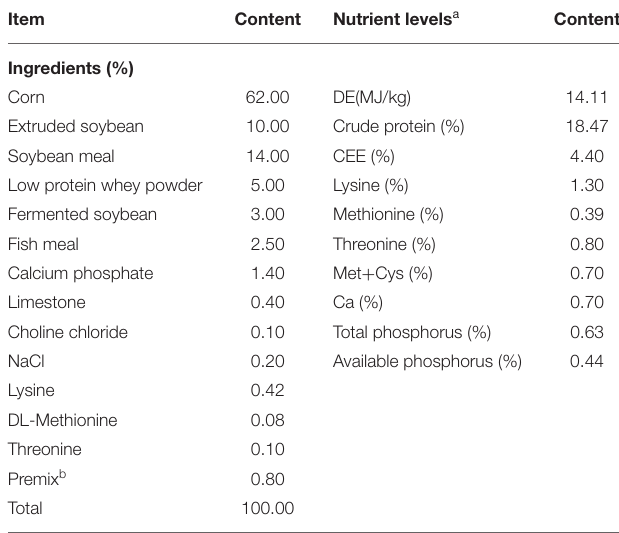
TABLE 1 | The composition of the basal